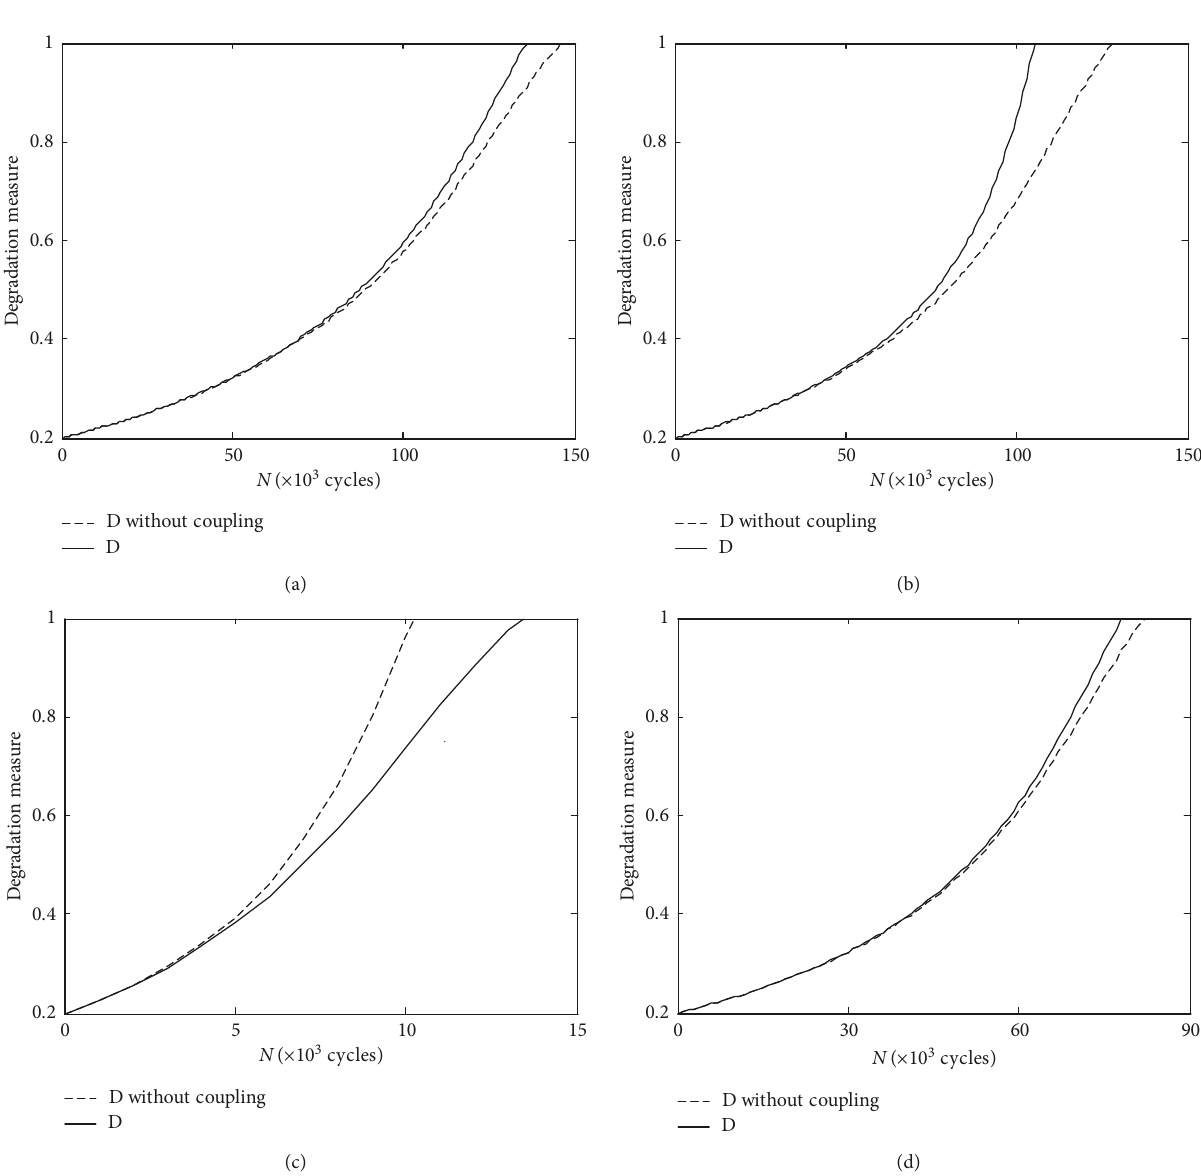
Figure 5: Degradation evolution presented by different degradation measures for different rotation speeds: (a) 1000rpm; (b) 3000rpm; (c) 5000rpm; (d)